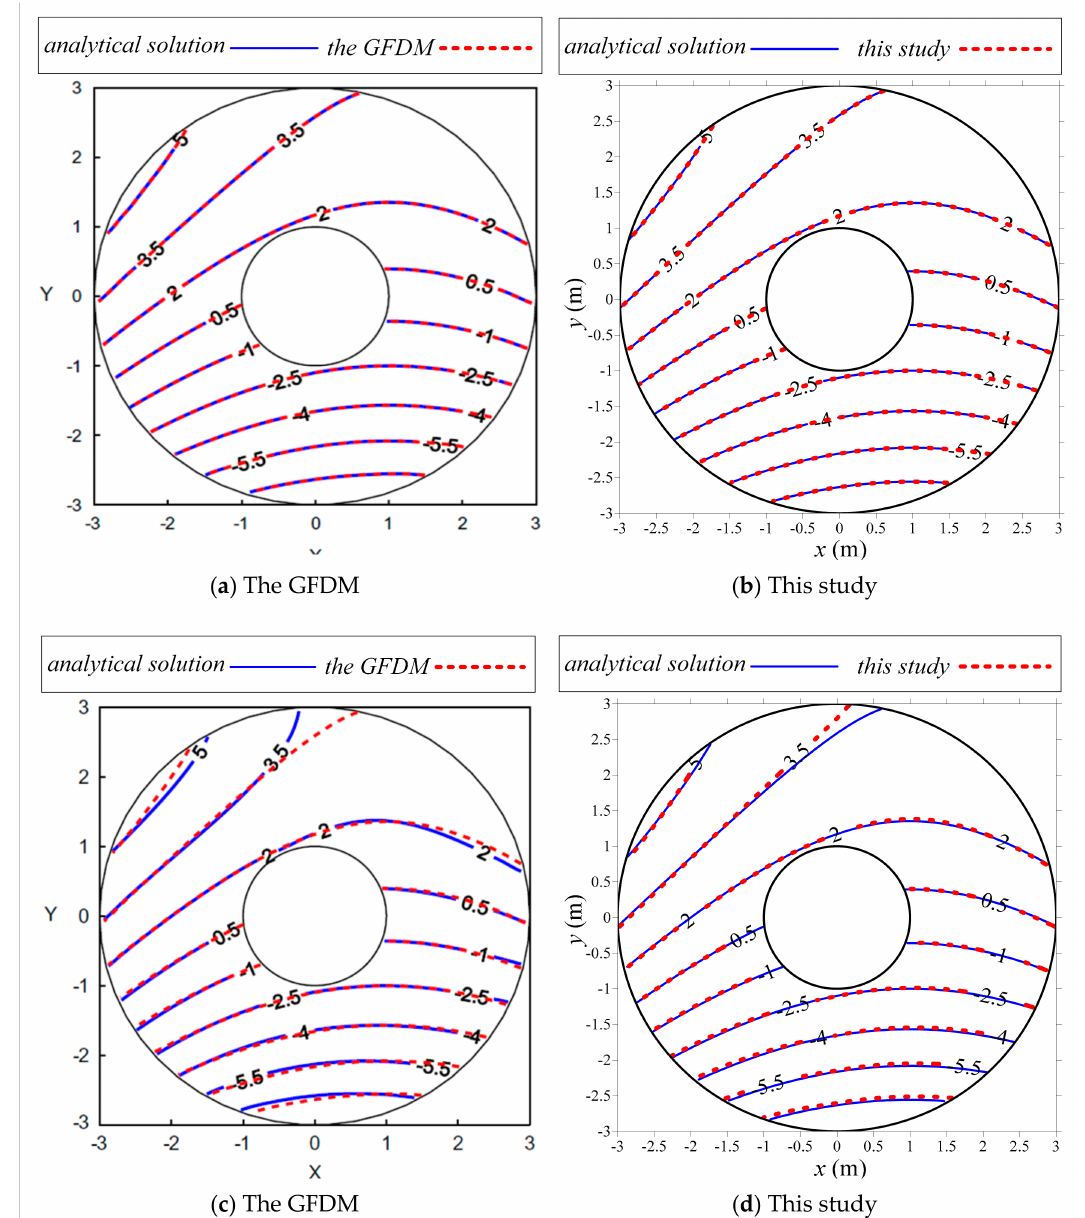
Figure 22. Comparison between the temperature fields of the proposed method and the generalized finite di ff erence method. ( a , b ) the computed results without the noise and the exact solution and ( c , d ) the computed results with a noise level of s = 3 and the exact